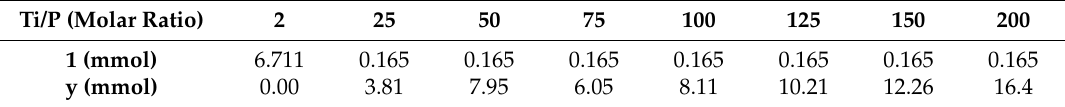
Table 4. Ratios of Ti/P and amounts of 1 , [Ti 2 (OiPr) 6 (O 3 PC 2 H 3 )] m and y , Ti(OiPr) 4 aimed